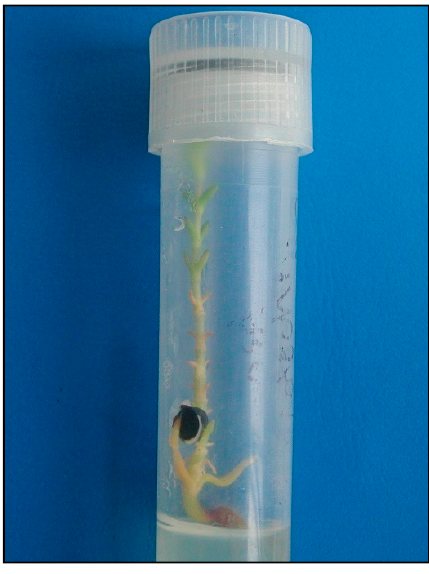
Figure 4. Micropropagation of Honckenya peploides : germinated seed.